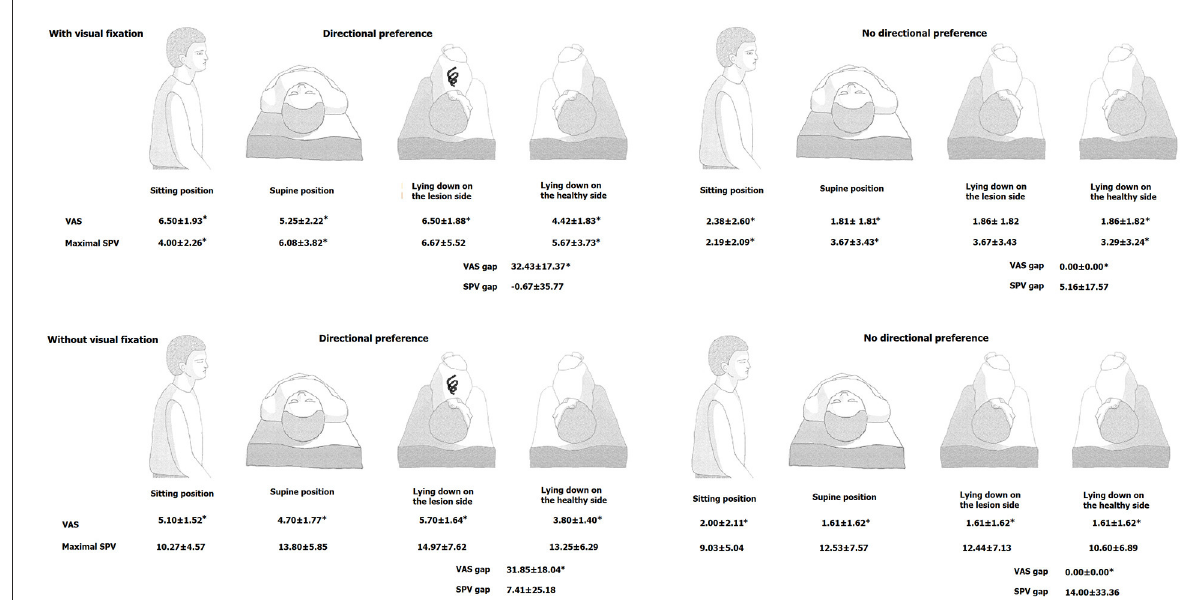
FIGURE1 Comparison of the intensity of spontaneous nystagmus (maximal SPV) and vertigo severity (VAS) at each position between patients with vs. without positional preference. (Upper) : under the visual fixation, (Lower) : without visual fixation. SP, slow phase velocity; SN, spontaneous nystagmus; VAS, visual analog scale. * p < 0.05: with vs. without positional